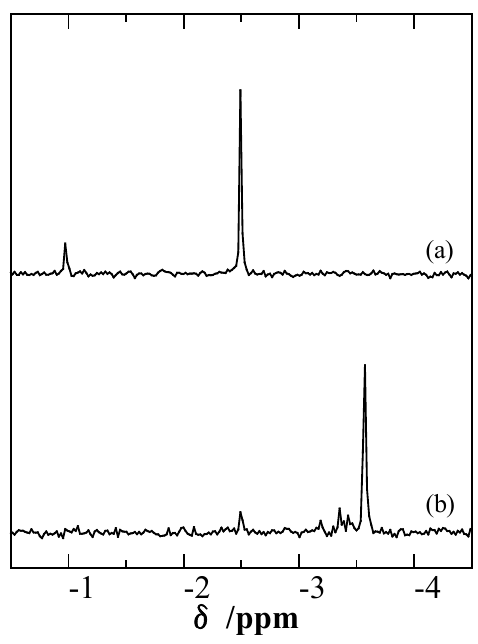
Figure 6. 31 P NMR spectra of a 100 mM Mo(VI)–100 mM P(V)–25 mM V(V)–1.0 M HCl system collected ( a ) after a solution without V(V) was heated at 80 °C for 30 h and ( b ) after V(V) was added and the solution was heated again at 80 °C for one